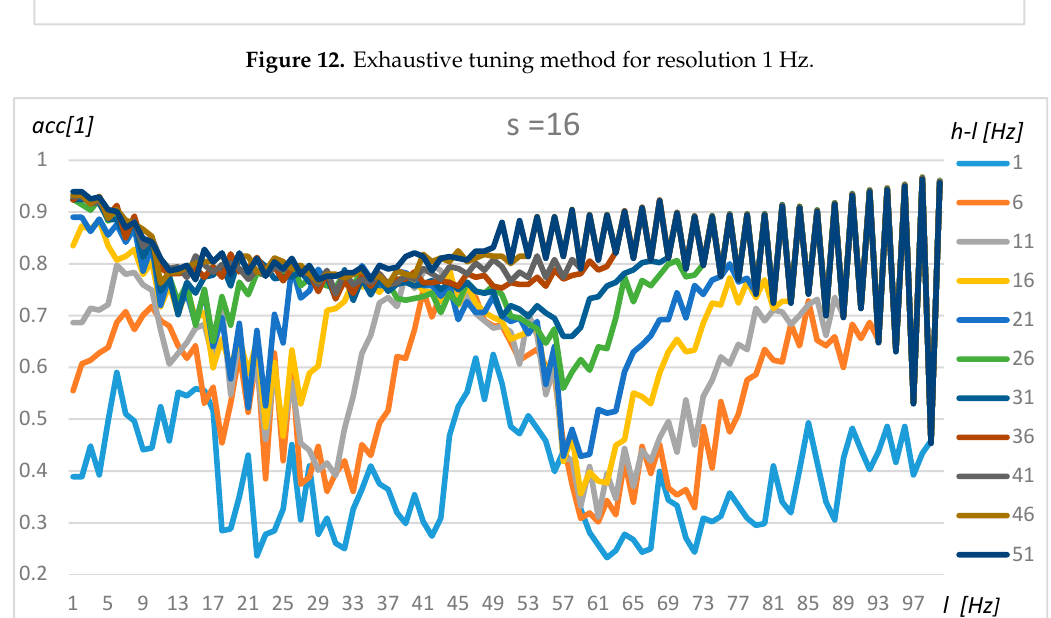
Figure 13. Exhaustive tuning method for resolution 2